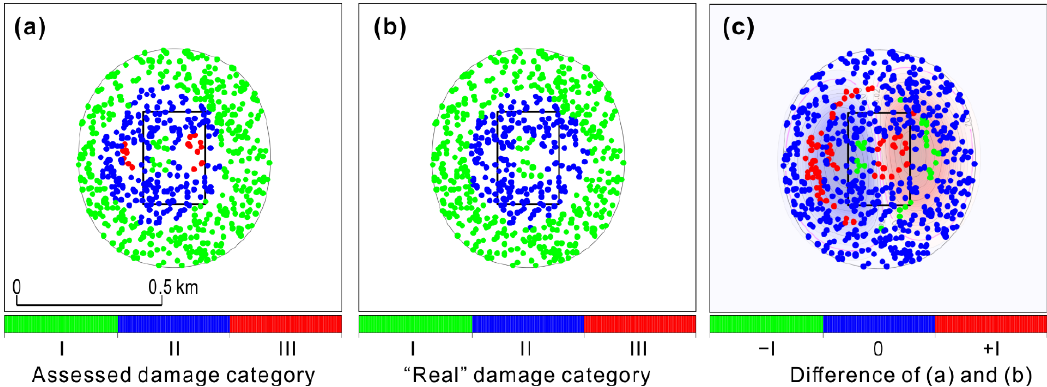
Figure 12. ( a , b ): Assessed and “real” damage categories of buildings (marked by circles) on the basis of the NOV-estimated and the simulated subsidence, respectively. ( c ) Differences between ( a ) and ( b ). The black ellipses in ( a – c ) denote the simulated subsidence boundary. The black rectangle denotes the simulated working panel. The base map in ( c ) shows the errors of the NOV-estimated subsidence. 5. Conclusions